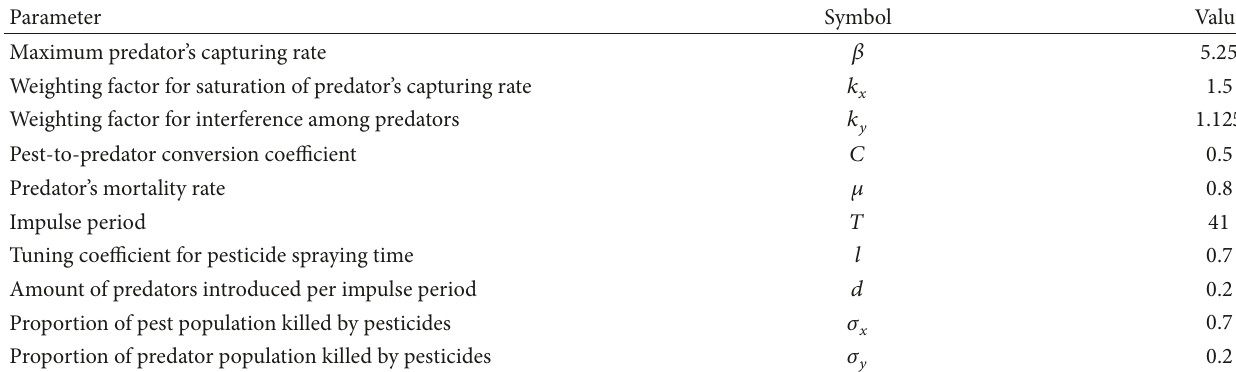
Figure 1: Periodic solution of the impulsive system (14) computed for the parameter values given in Table 1. (a) and (b) show the time histories of the pest and predator populations, respectively, while (c) presents the corresponding phase plot with the solution segments 𝐼 1 (pesticide spraying, blue) and 𝐼 2 (predator release, red). Hence, the displayed periodic trajectory has a cyclic solution signature {𝐼 1 , 𝐼 2 } . In what follows, this color code will be used to distinguish the solution segments. Table 1: Parameter values used for the numerical investigation of the impulsive model